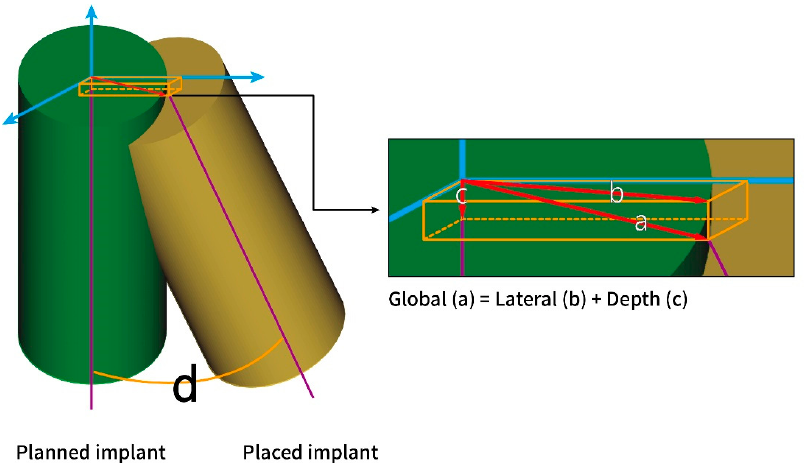
Figure 5. Definitions of the deviations measured at the implant platform: ( a ) global deviation, ( b ) lateral deviation, ( c ) depth deviation, and ( d ) angular deviation. The identical coordinate system (blue arrows) was used to measure the deviations at the implant apex. Appl. Sci. 2020 , 10 , x FOR PEER REVIEW